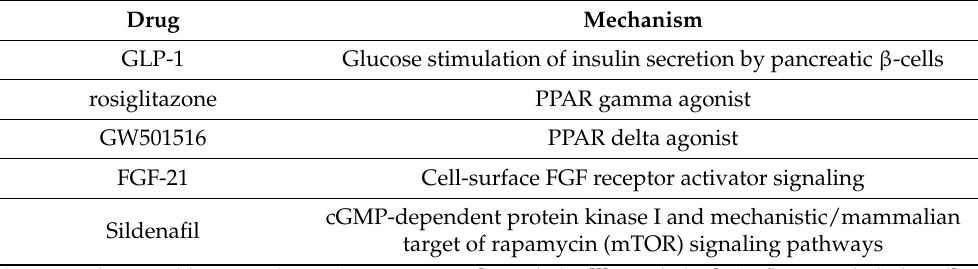
Table 1. Browning agents as anti-obesity treatments. Drug Mechanism GLP-1 Glucose stimulation of insulin secretion by pancreatic β -cells